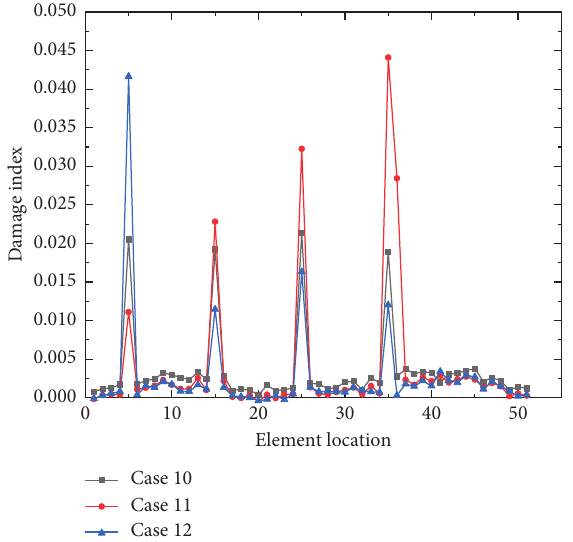
Figure 13: Damage detection results of cases 10–12.